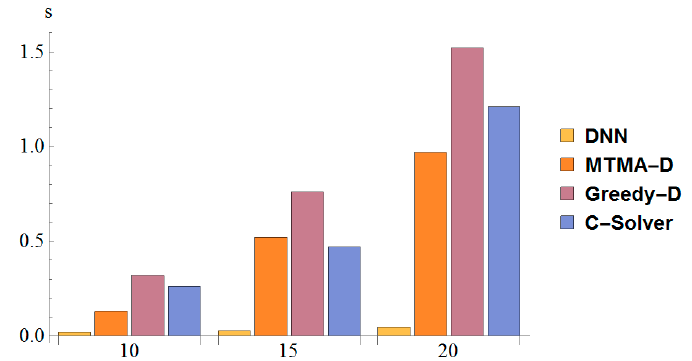
Figure 4. Comparison of computation time.